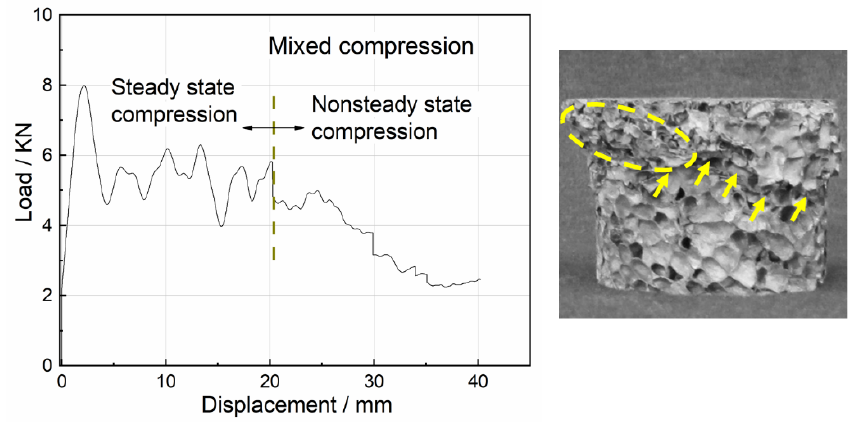
Figure 11. Load–displacement curve for mixed compression and damaged specimen.